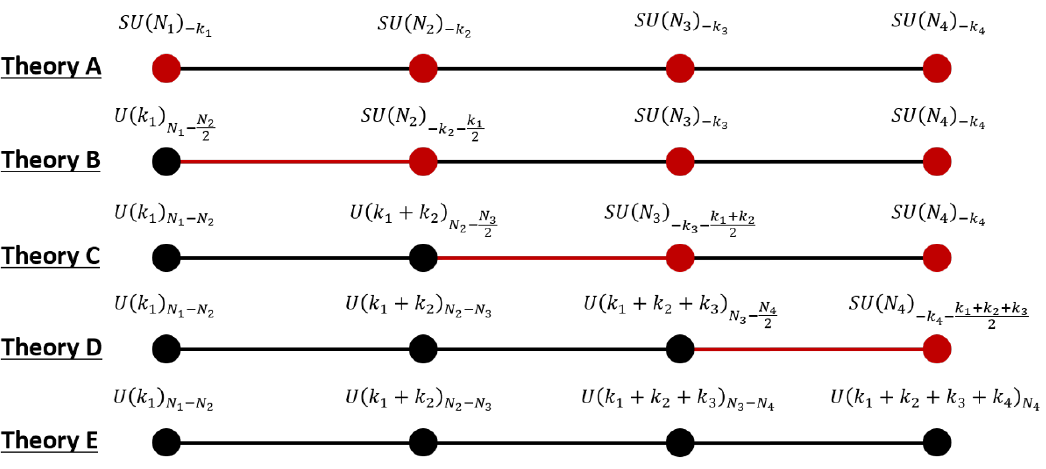
Figure 3 . Dualizing a linear quiver. Red nodes are SU gauge groups and black nodes are U groups. Black (red) links are bifundamental bosons (fermions). Applying Aharony’s duality to the leftmost link turns the scalar into a fermion. Then, applying the master duality repeatedly moves said fermion across the quiver until it reaches the (cid:12)nal link where Aharony’s duality can again be used to turn the fermion into a